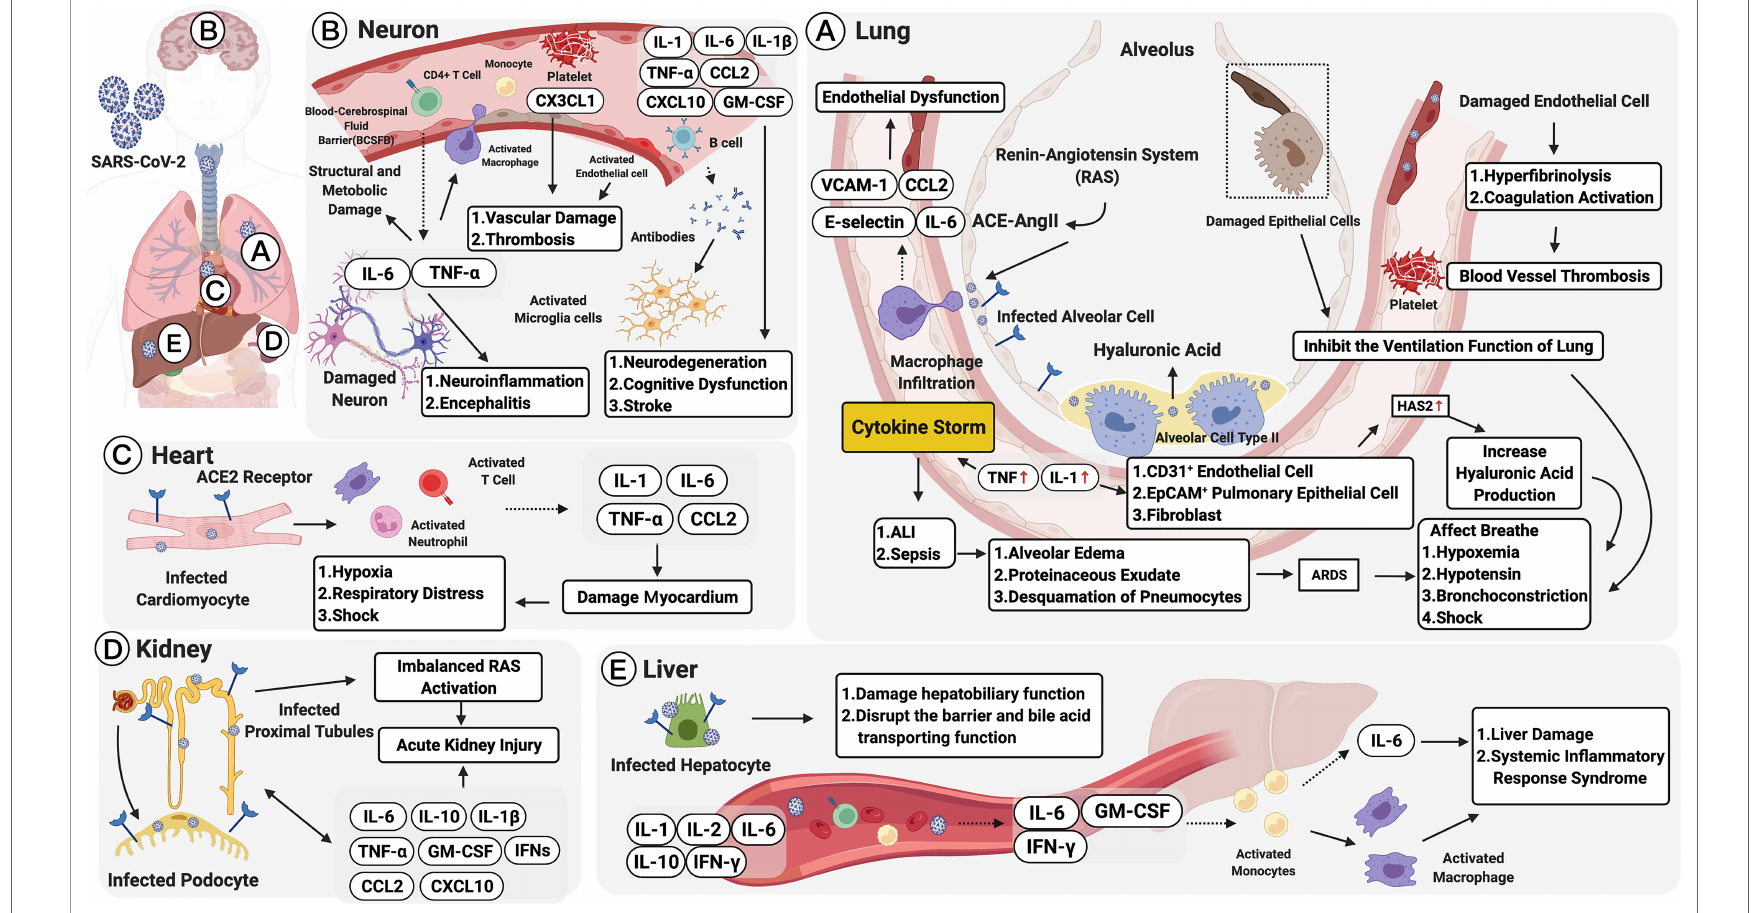
FIGURE 2 | Multiple organ failure in SARS-CoV-2: pulmonary and extrapulmonary manifestations. Pulmonary manifestations: (A) Alveolar cells are infected by the angiotensin-converting enzyme 2 (ACE2) receptor. This leads to acute lung injury (ALI), activation of the renin-angiotensin system (RAS), and macrophage recruitment. Macrophages, activated by the ACE2-Ang II axis, can secrete IL-6, CCL2, VCAM-1, and E-selectin leading to endothelial dysfunction. Damaged endothelial cells may cause hyper fi brinolysis, activate coagulation, and increase in fl ammatory cytokine levels (IL-1 and TNF), which are strong inducers of hyaluronic acid- synthase-2 (HAS2) in CD31 + endothelium, EpCAM + lung alveolar epithelial cells, and fi broblasts. The increased hyaluronic acid may cause bronchoconstriction. Extrapulmonary manifestations: (B) In neurons, elevated TNF- a and IL-6 secretions could increase the in fi ltration of immune cells and the permeability of the blood and cerebrospinal fl uid barrier (BCSFB). CX3CL1 could also promote neurological vascular damage and thrombosis. IL-6 along with GM-CSF, IL-1 b , TNF- a , CCL2, and CXCL10, could increase the severity of neurodegeneration, cognitive dysfunction, and stroke. (C) In the heart, infected cardiomyocytes would induce elevated secretions of IL-1, IL-6, TNF- a , and CCL2, damaging the myocardium and developing into hypoxia, respiratory distress, and even shock. (D) In the kidney, SARS-CoV-2 infects ACE2 expressing proximal tubules and the podocytes. The infected podocytes promote an imbalanced RAS, which leads to acute kidney injury (AKI). Moreover, IL-6, IL-1 b , IL-10, GM-CSF, IFNs, CXCL10, CCL2 and TNF- a promote AKI persistence. (E) In the liver, infected hepatocytes trigger elevated serum IL-1, IL-2, IL-6, IL-10, and IFN g , as well as pathogenic cytokine secretions mediated by T cells (GM-CSF, IL-6, and IFN- g ). The immune-mediated injury would lead to liver dysfunction and systemic in fl ammatory response syndrome (SIRS). Figure created with